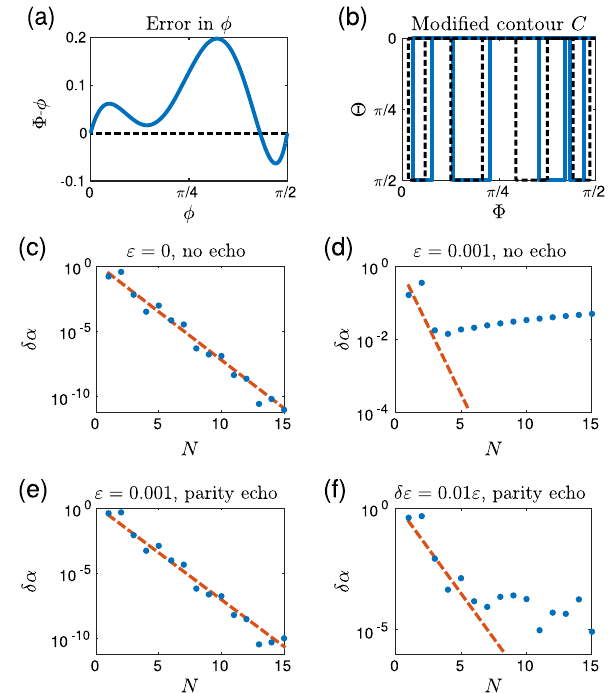
FIG. 5. Numerical demonstration of the robustness of the π = 8 gate. (a) Systematic deviation of the angle Φ from its perfect implementation ϕ (dashed black line). The corresponding modi- fied contour for N ¼ 4 (solid blue line) is depicted in (b) and shows clear variations from the perfect implementation (dashed black line). (c) The relative error in the phase gate angle δα , which decays exponentially with the number of turns N . (The dashed red line shows the exponential fit.) (d),(e) Effect of a finite outer coupling [ ε ¼ 0 . 001 , cf. Eq. (17)] without and with an accom- panying parity echo (see Sec. IV). (f) An imperfect echo implementation where ε changes by δε ¼ 0 . 01 ε between the echo